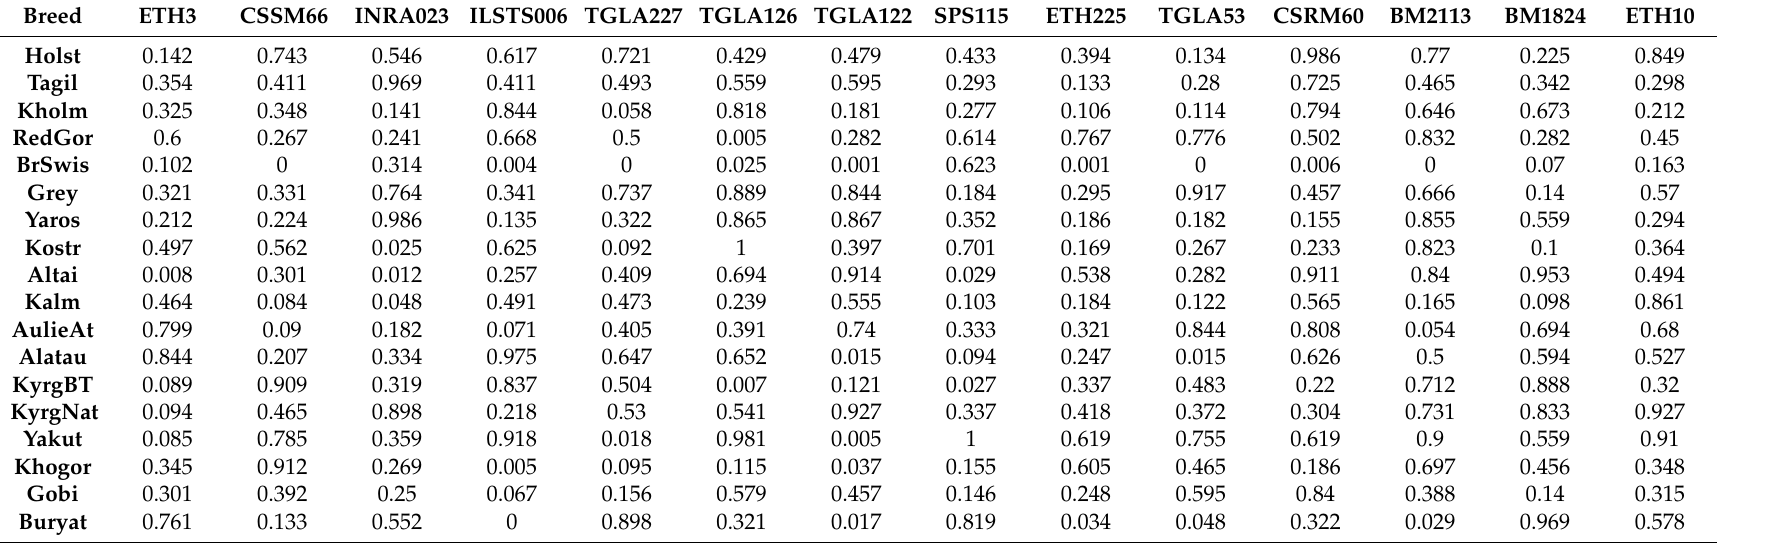
Table A2. The p -values for the Hardy–Weinberg equilibrium test for each combination of sample and